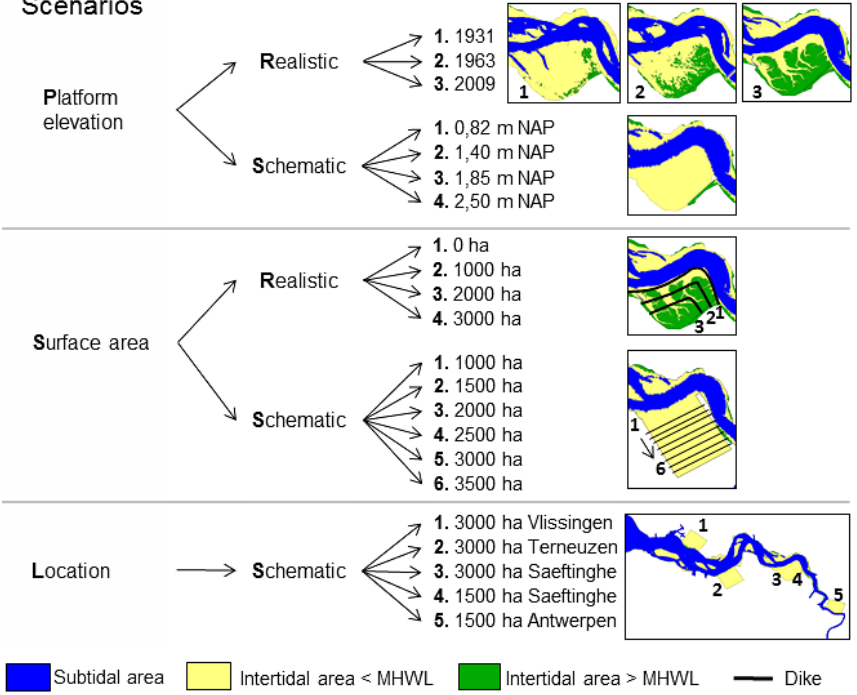
Figure 2. Schematic summary of the scenarios (see explanations in the text). The colours used in the small maps indicate the subtidal area ( < − 2m NAP) in blue, the intertidal area below MHWL ( > − 2m NAP and < 2.5m NAP) in light yellow and the intertidal area above MHWL ( > 2.5m NAP) in green. The black line is an indication for the location of a